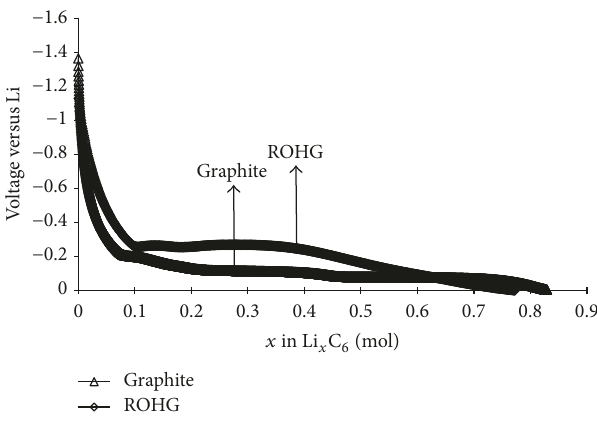
Figure 4: Plot of moles of Li versus voltage with reference to Li metal. Table 1: Entropy and enthalpy data for ROHG at 296 ∘